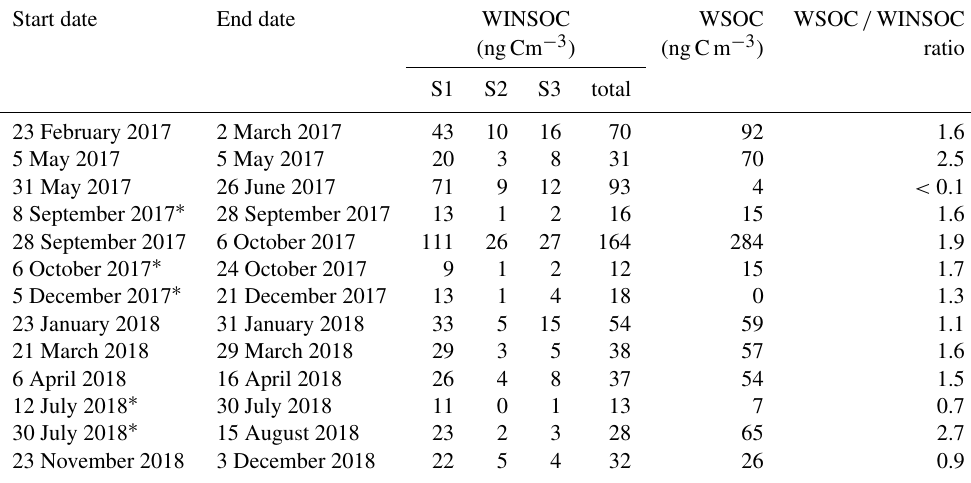
Table 2. WINSOC amounts for each step of the Swiss_3S protocol measured at the University of Bern and corresponding WSOC amounts. Fraction S1 is considered pure WINSOC, whereas S2 and S3 are mixed fractions of WINSOC and EC. WSOC was determined by subtraction of EC and total WINSOC from